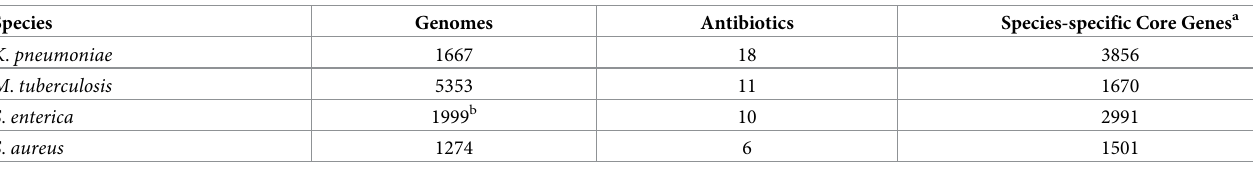
Table 1. Data sets used in this